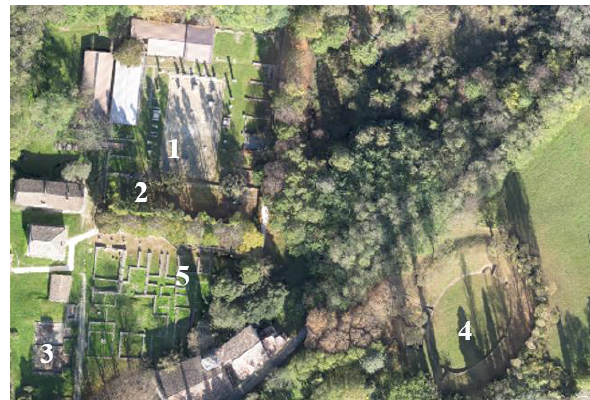
Figure 3. The overall extension surrounded by vegetation of the Veleia archaeological site: 1- the bore; 2- the Basilica; 3- the thermal baths; 4- the cistern; 5- the residential district.